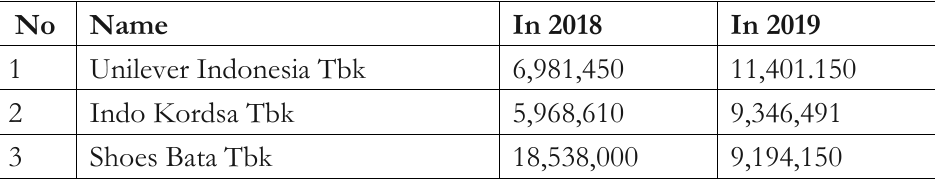
Table 1. Dividend Policy (In